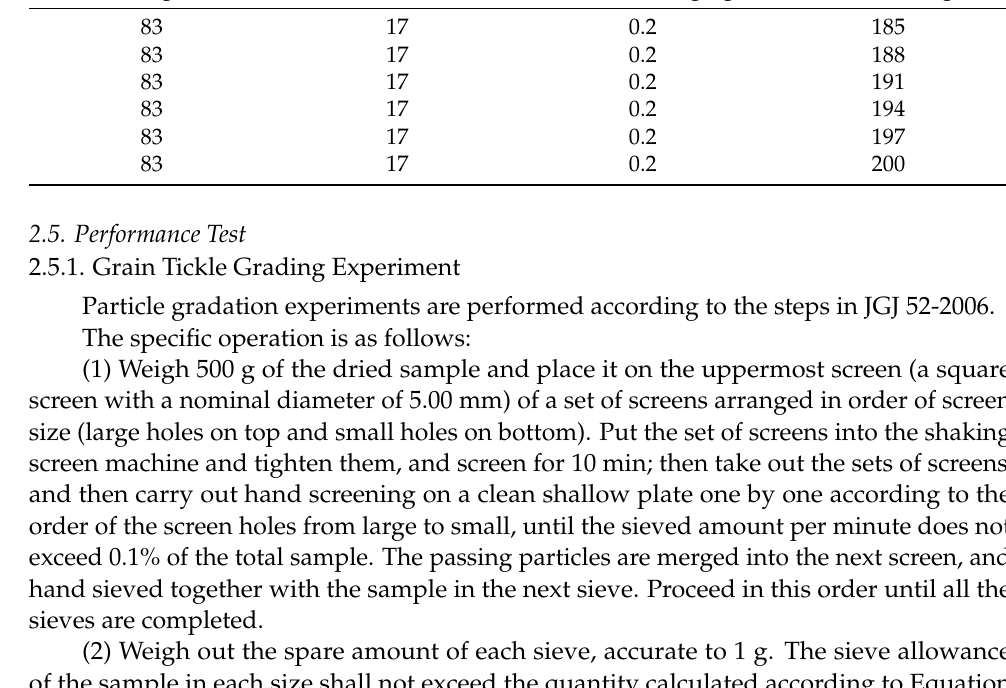
Table 6. Data of base ratio of different water addition. Coal Gangue (%) Cement